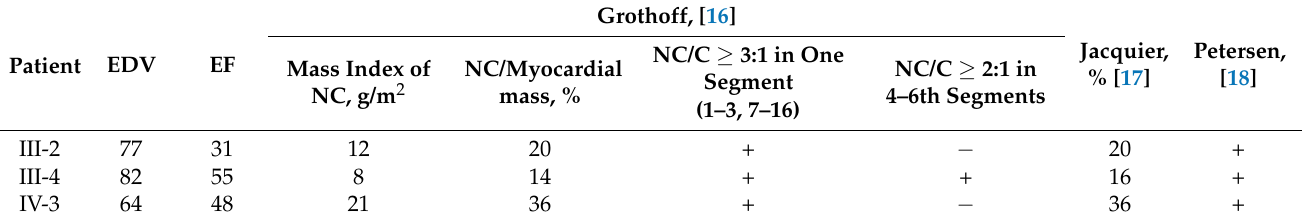
Table 2. Magnetic resonance imaging